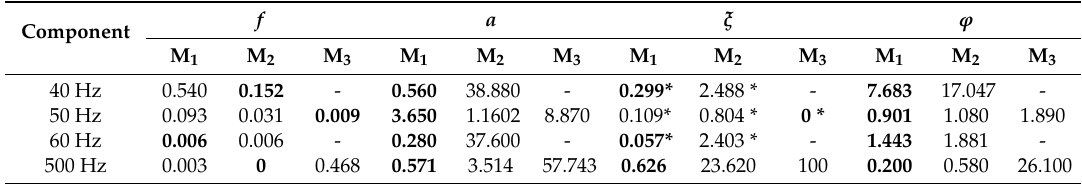
Figure 6. Source signal and the reconstruction of (25) by using ( a ) The proposed method; ( b ) TLS-ESPRIT; ( c ) Prony method. Table 2. Comparative analysis of the proposed method, Prony method (order = 8), and the TLS-ESPRIT (order = 8)/%. Component